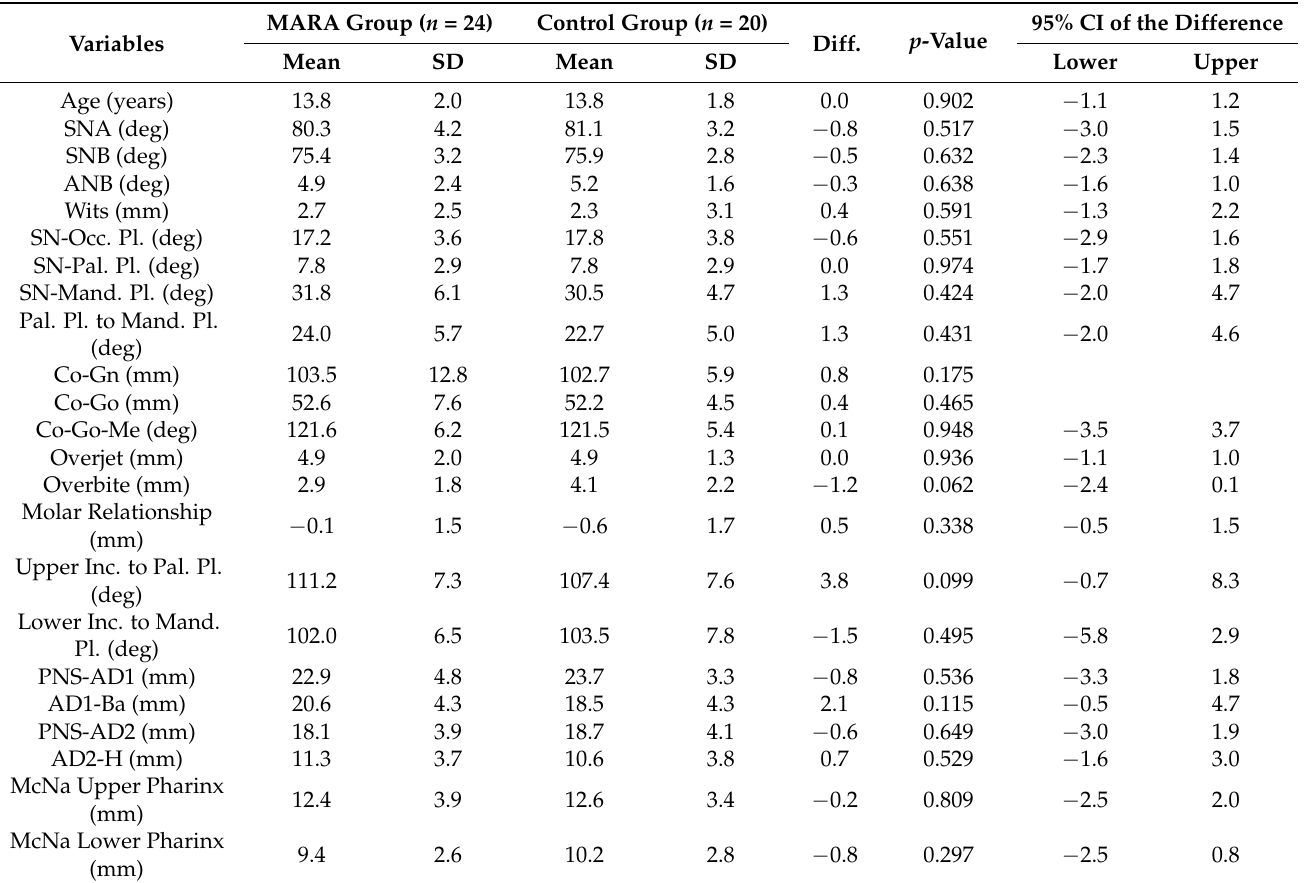
Table 2. Descriptive statistics and statistical comparisons (independent-samples t -tests or Mann– Whitney U test) of the starting forms (cephalometric values at